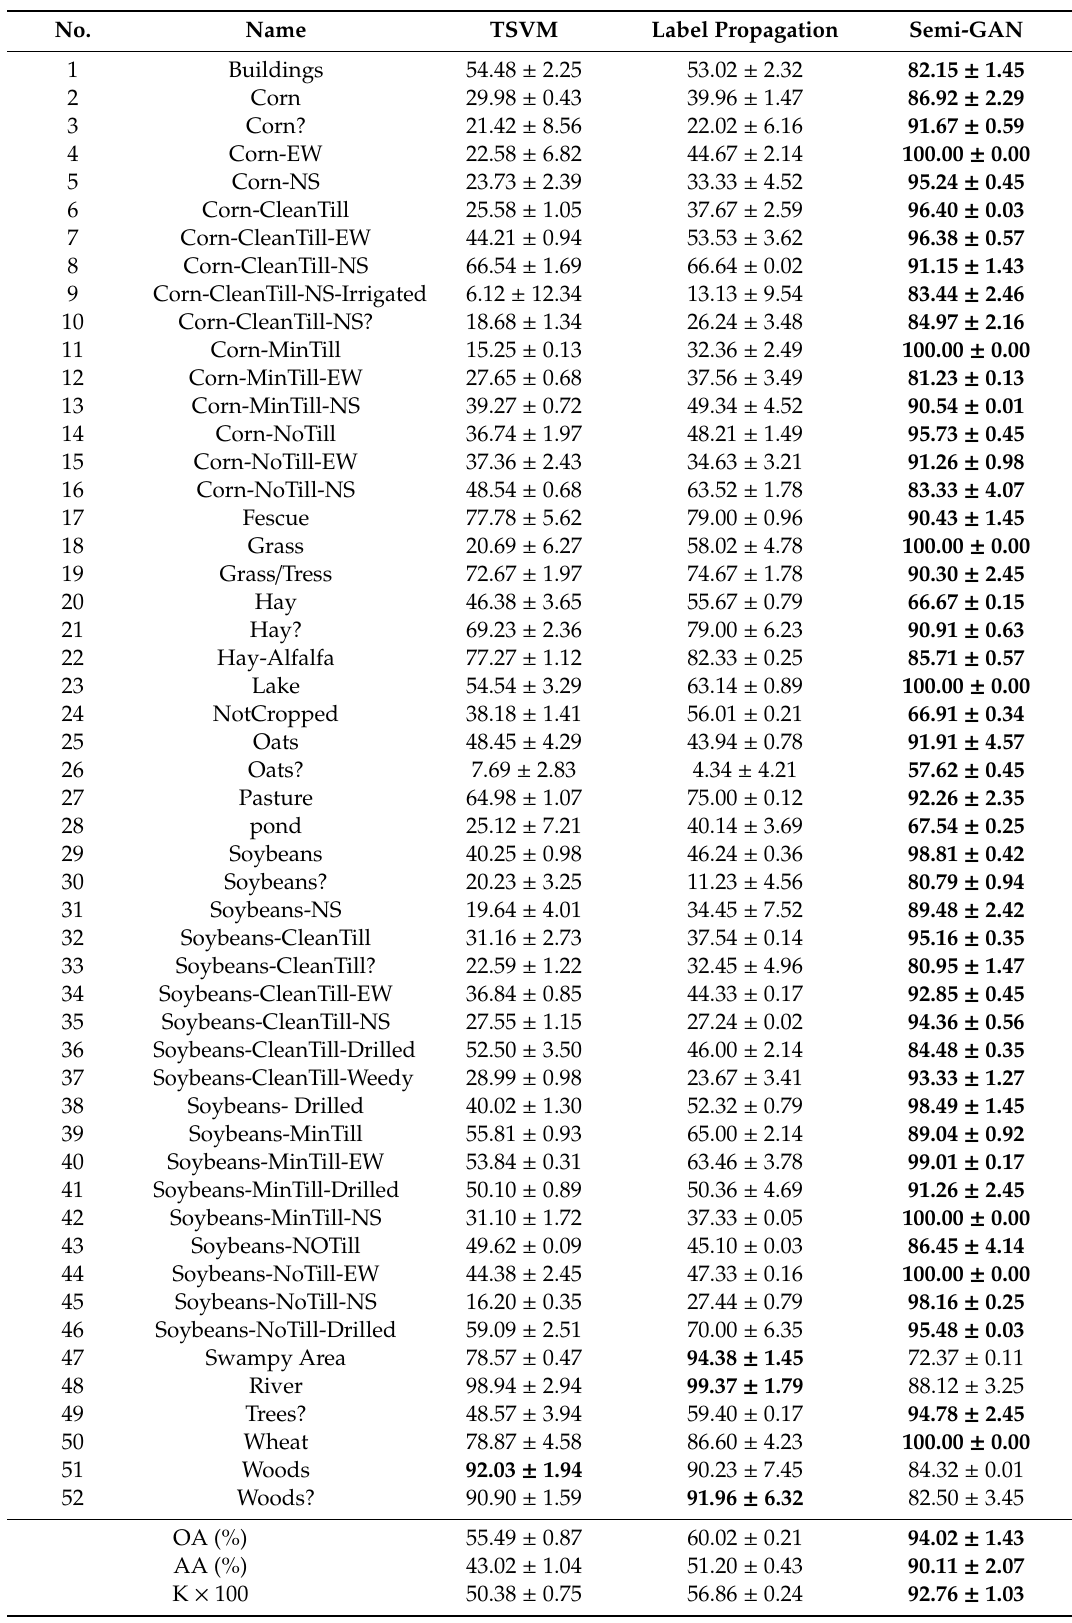
Table 8. Test accuracy with di ff erent semi-supervised methods on the Indian Pines dataset.